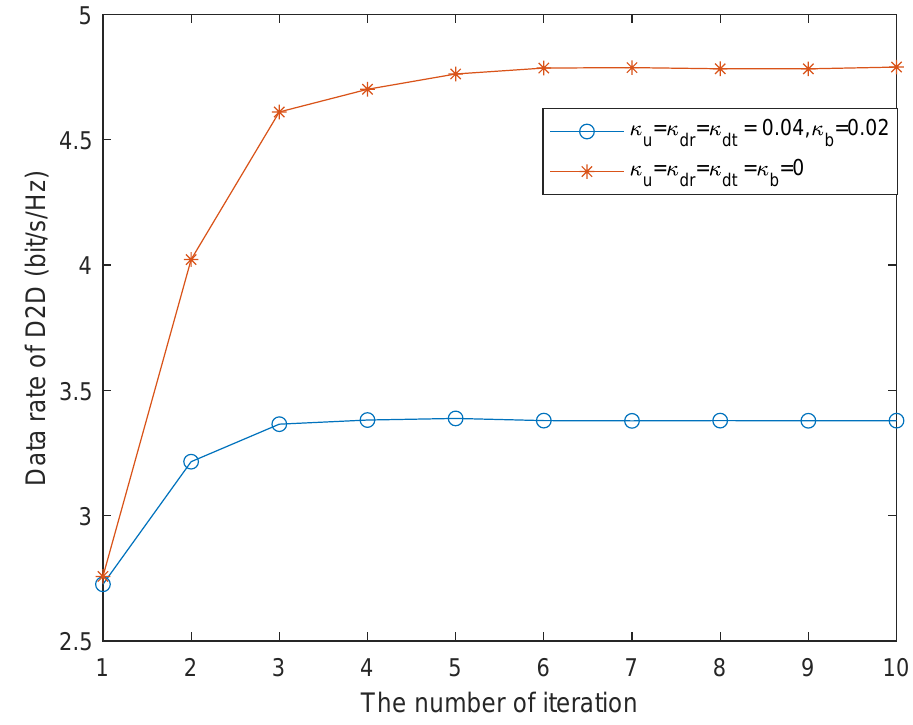
Figure 3. Convergence behavior of Algorithm